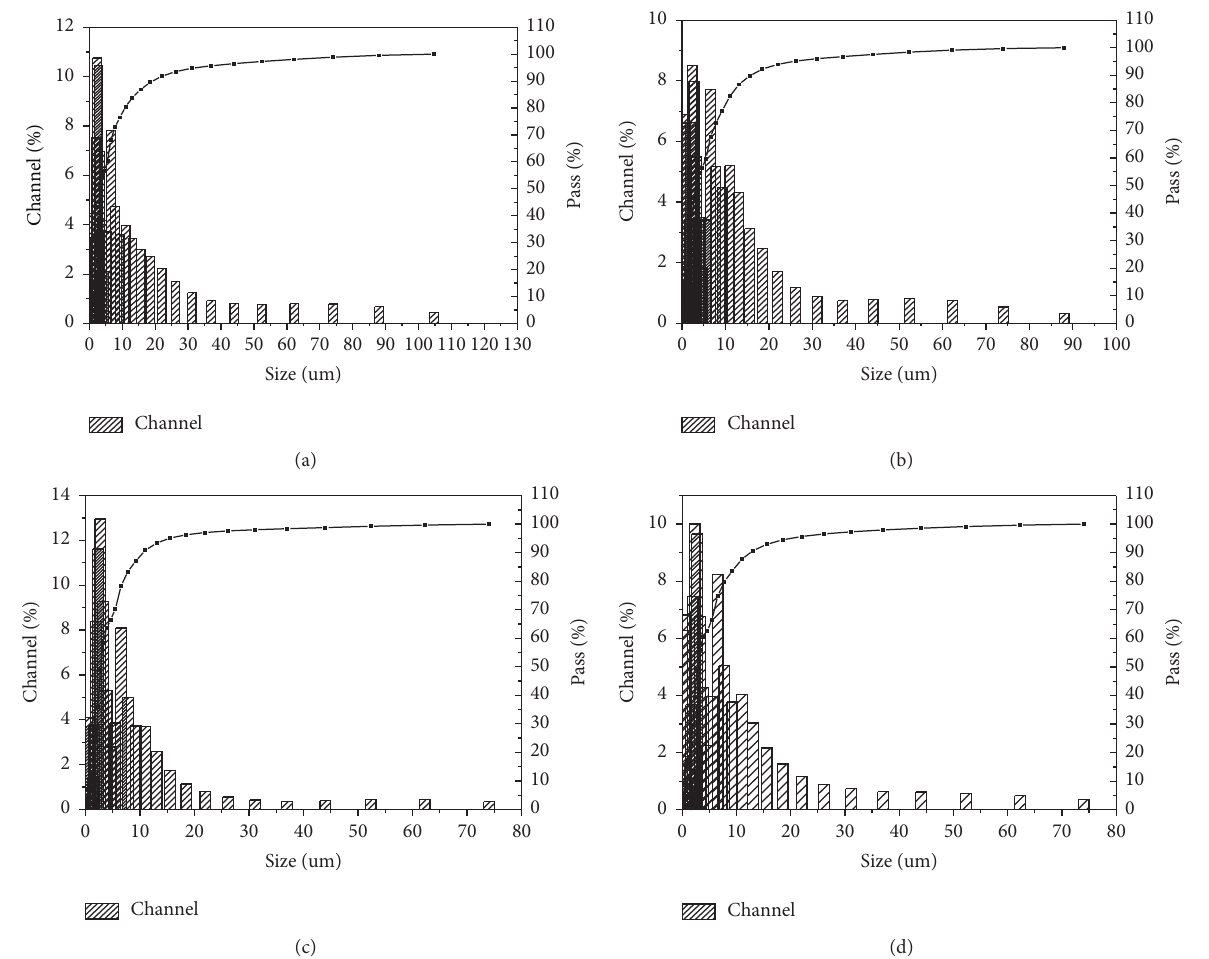
Figure 10: Particle size distribution of the water samples with different removal rates. (a) Raw water. (b) Effluent with a removal rate of 58.34%. (c) Effluent with a removal rate of 41.48%. (d) Effluent with a removal rate of